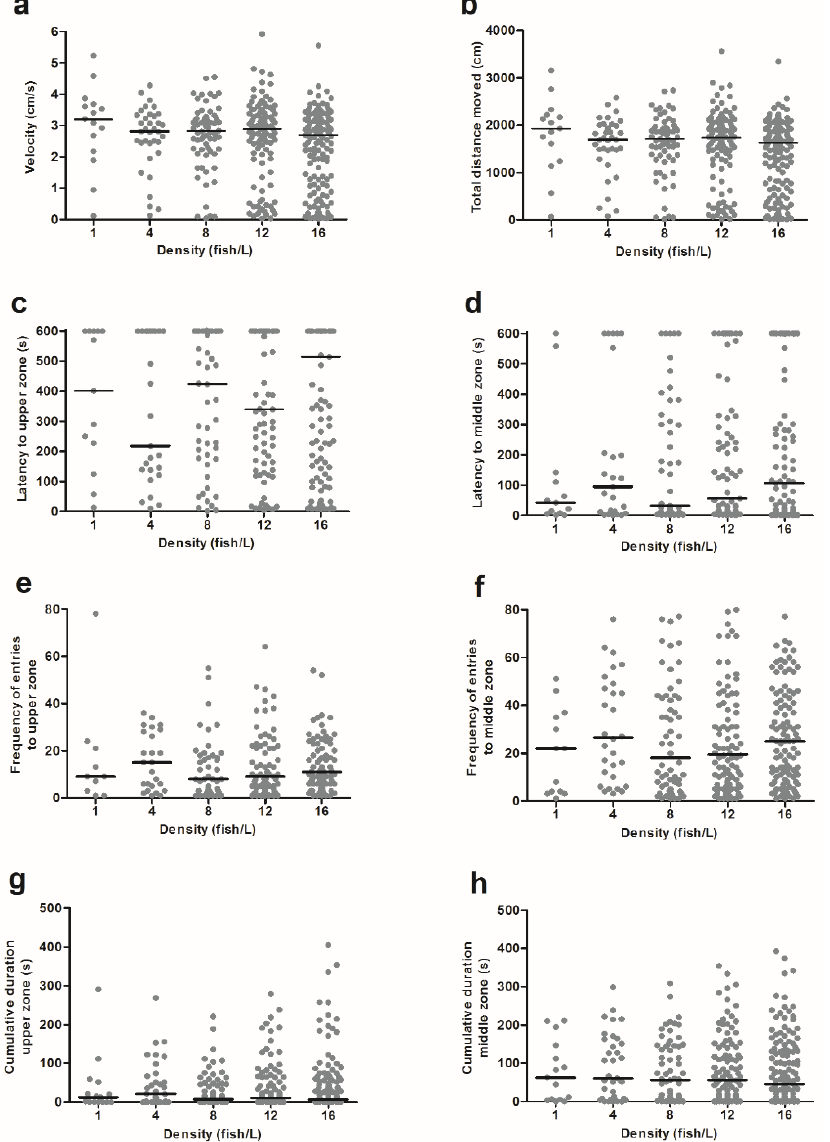
Figure 2. The behavioural responses in the novel tank diving test by zebrafish from holding densities of 1 ( n = 15), 4 ( n = 35), 8 ( n = 65), 12 ( n = 104), or 16 ( n = 139) fish/L, respectively. Graphs show ( a ) velocity, ( b ) total distance moved, ( c ) latency to the upper zone, ( d ) latency to the middle zone, ( e ) frequency of entries to the upper zone, ( f ) frequency of entries to the middle zone, ( g ) cumulative duration in the upper zone, and ( h ) cumulative duration in the middle zone. Data points correspond to individual fish and medians are illustrated as lines. No statistically significant differences were found between the treatments. Each video analysis for the novel tank diving test lasted for 600 s.